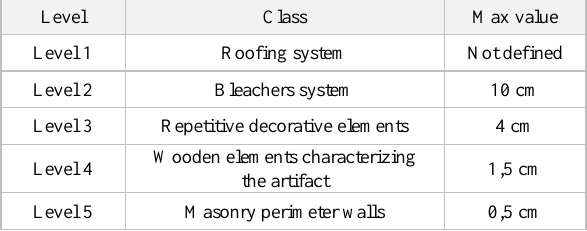
Table 2 . Standard deviation levels adopted for the modeling of 5 classes of elements identified in the Farnese